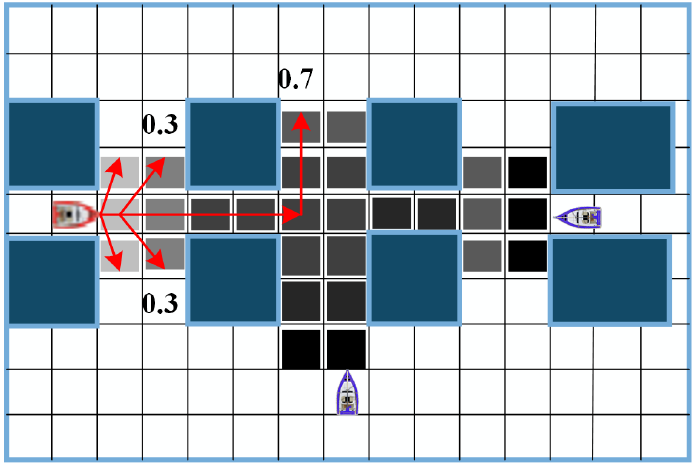
Figure 2. Demonstrationofintruderstrategymodel. Thedarkerthegrid,